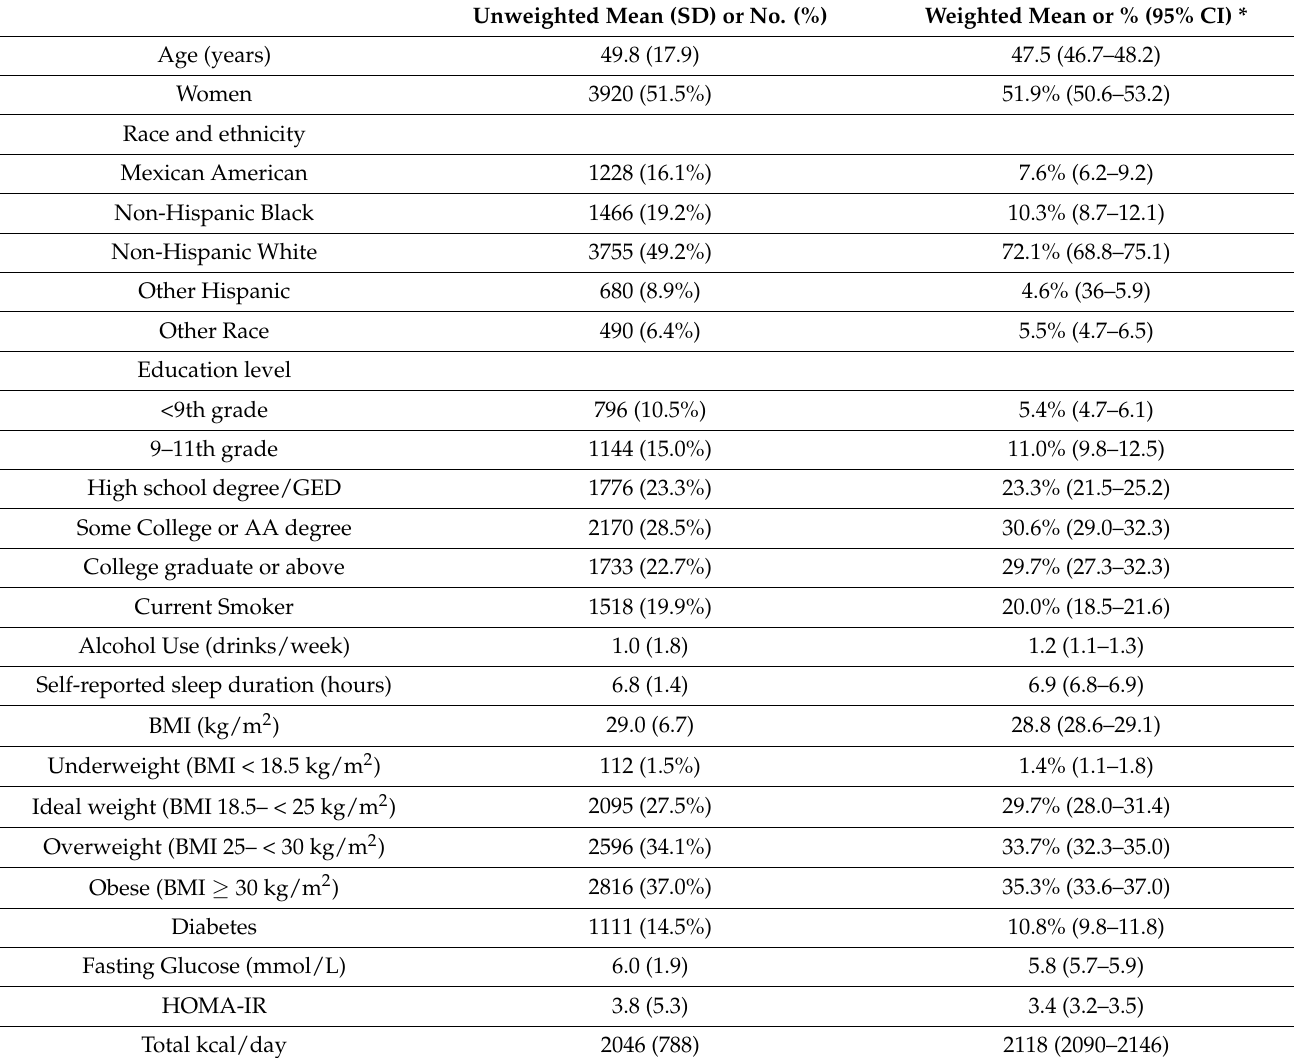
Table 1. Description of primary exposure and outcome measures (n =